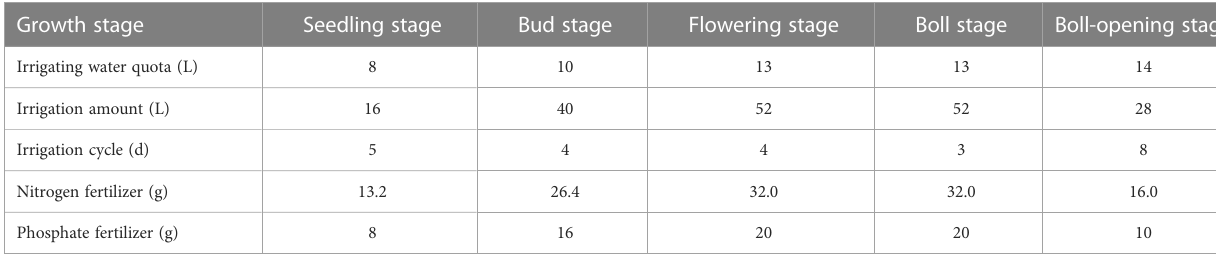
TABLE 1 Irrigation and fertilization scheme.